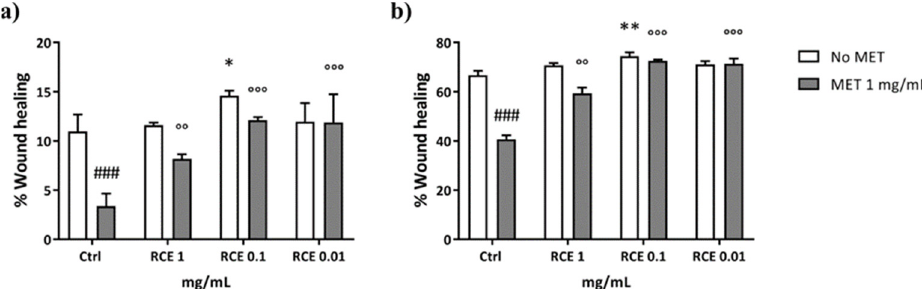
Figure 3. Wound healing activity on keratinocytes of RCE (RC-P extracts) after ( a ) 6 and ( b ) 24 h of treatment, in the absence and presence of MET (6 α -methylprednisolone). Two-way ANOVA, followed by Sidak post-hoc ### p < 0.001 vs. Ctrl; * p < 0.05 vs. Ctrl; ** p < 0.01 vs. Ctrl; °° p < 0.01 vs. MET; °°° p < 0.001 vs. MET.